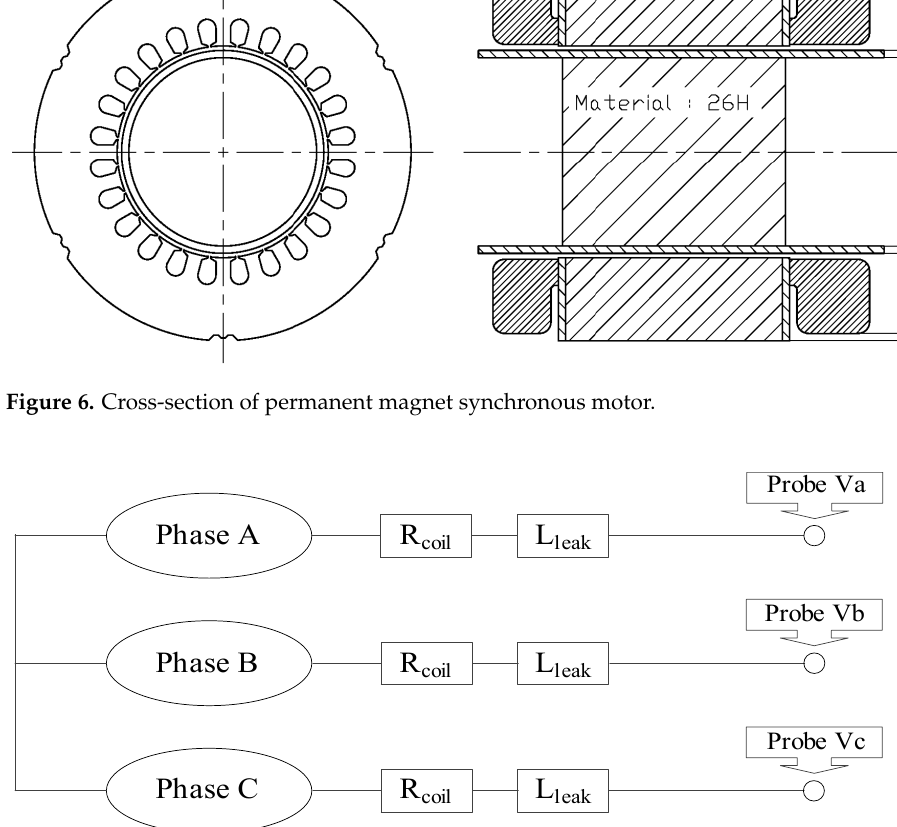
Figure 7. Back-EMF simulation circuit.